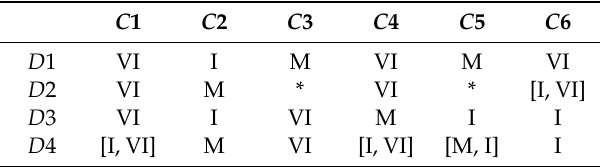
Table 1. Semantic variables of the criterion weights for the five alternatives. C 1 C 2 C 3 C 4 C 5 C 6 D 1 VI I M VI M VI D 2 VI M * VI * [I, VI] D 3 VI I VI M I I D 4 [I, VI] M VI [I, VI] [M, I] I The missing values are shown with